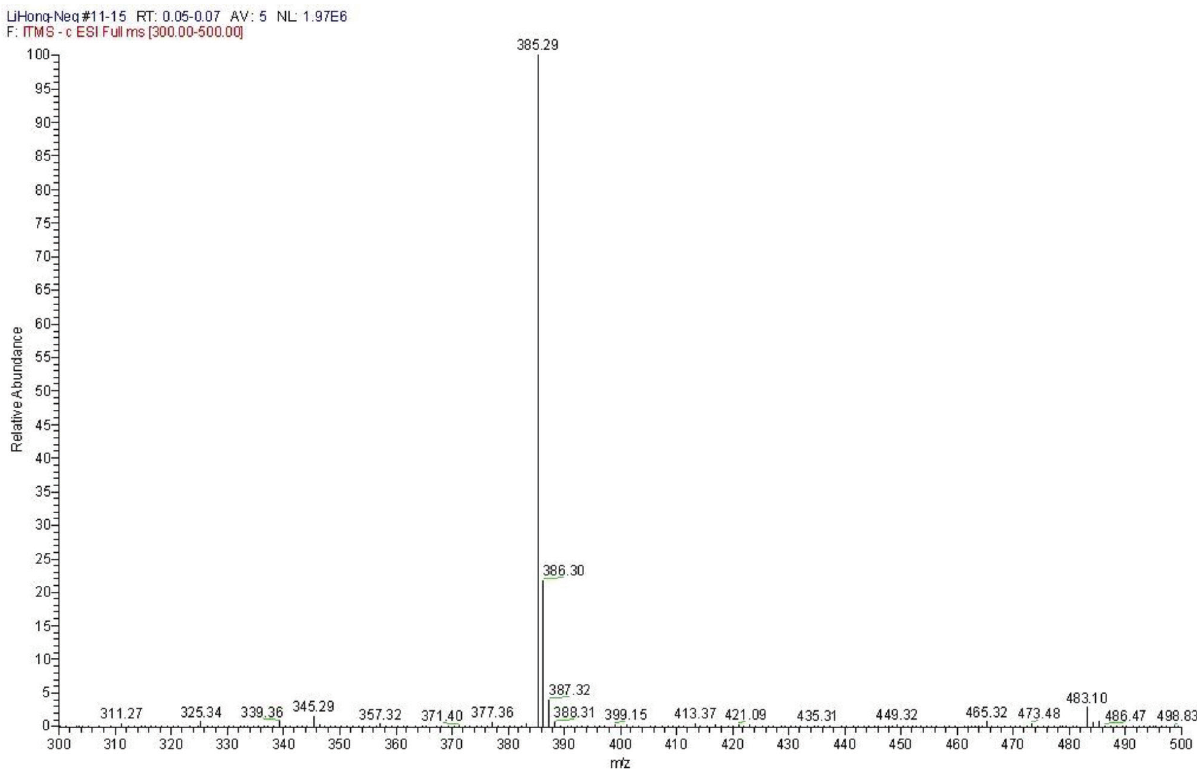
Fig. 2 – ESI-MS of l -ascorbyl